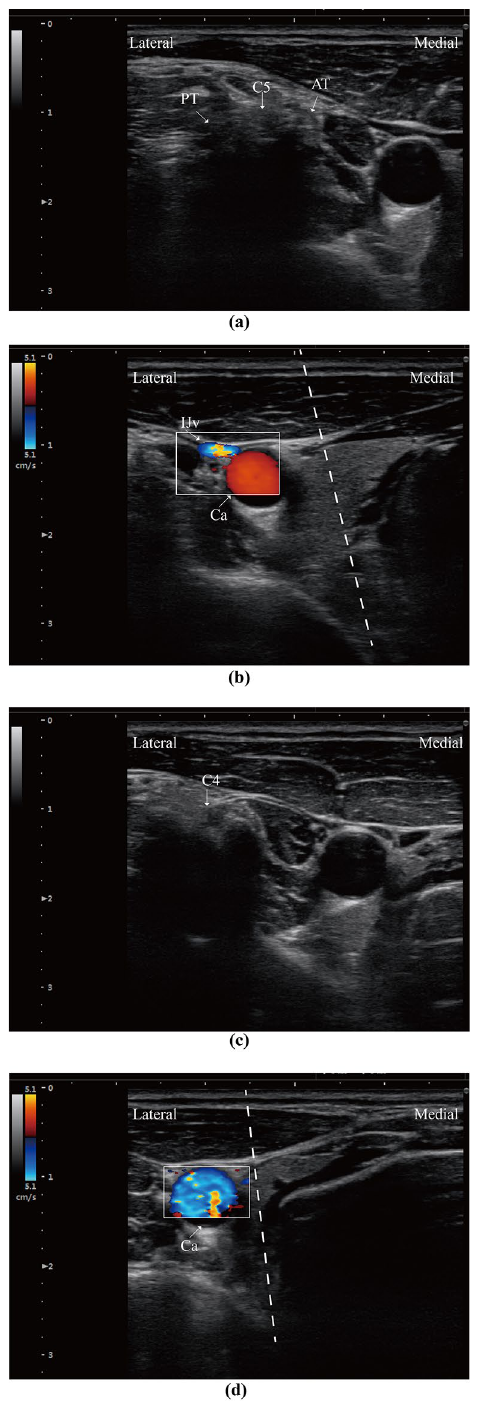
Figure 4. Ultrasound-guided cannulation for upper cervical intervertebral space. ( a , b ) Imaging scan of C5 level, and placement of cannula into the C4/5 disc. ( c ) Sonography of C4 cervical nerve root. ( d ) Cannulation pathway for C3/4 intervertebral